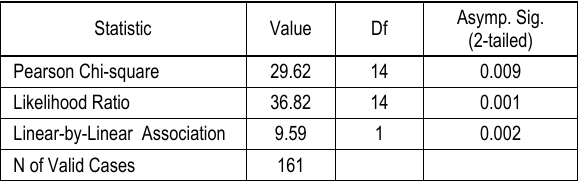
Table 4. Chi-square test for access to financial